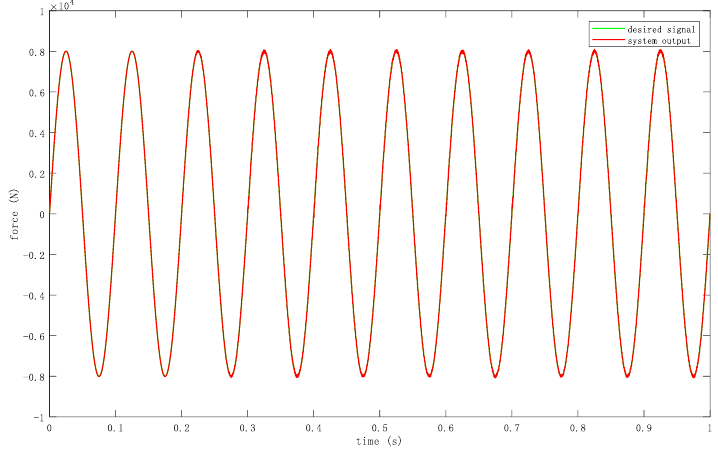
Figure 18. System loading output at 10 Hz frequency.